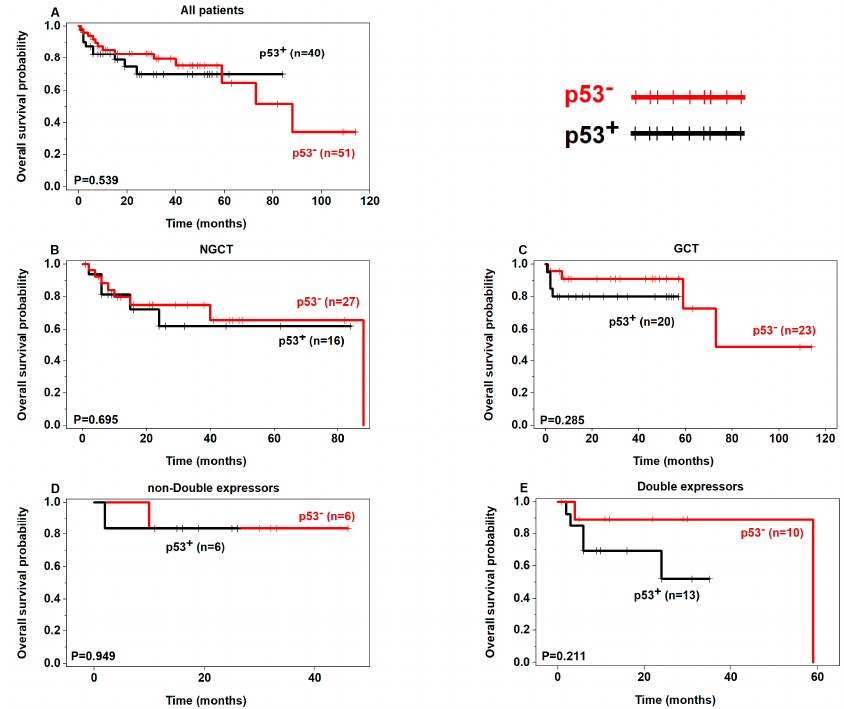
Figure 2. Prognostic analysis of p53 expression in DLBCL (OS) (p53+ in black, p53– in red).